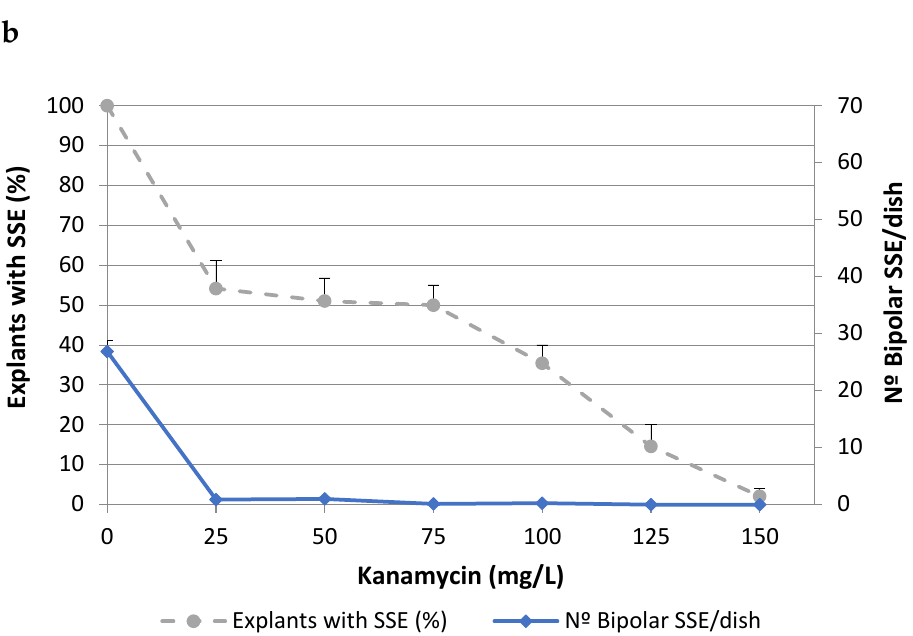
Figure 1. Effect of kanamycin concentration on percentage of explants with secondary somatic embryos (SSEs) and on the number of bipolar SSEs per Petri dish, in the genotypes ALM80 ( a ) and TGR3 ( b ). Vertical lines indicate the standard errors of mean values. Table 1. Effect of different combinations/concentrations of bacteriostatic antibiotics on somatic embryo proliferation in cork oak embryogenic genotypes TGR3 and ALM80. Number of Bipolar Antibiotics Explants with SSE (%) Antibiotics SSE/Dish (mg/L) TGR3 ALM80 TGR3